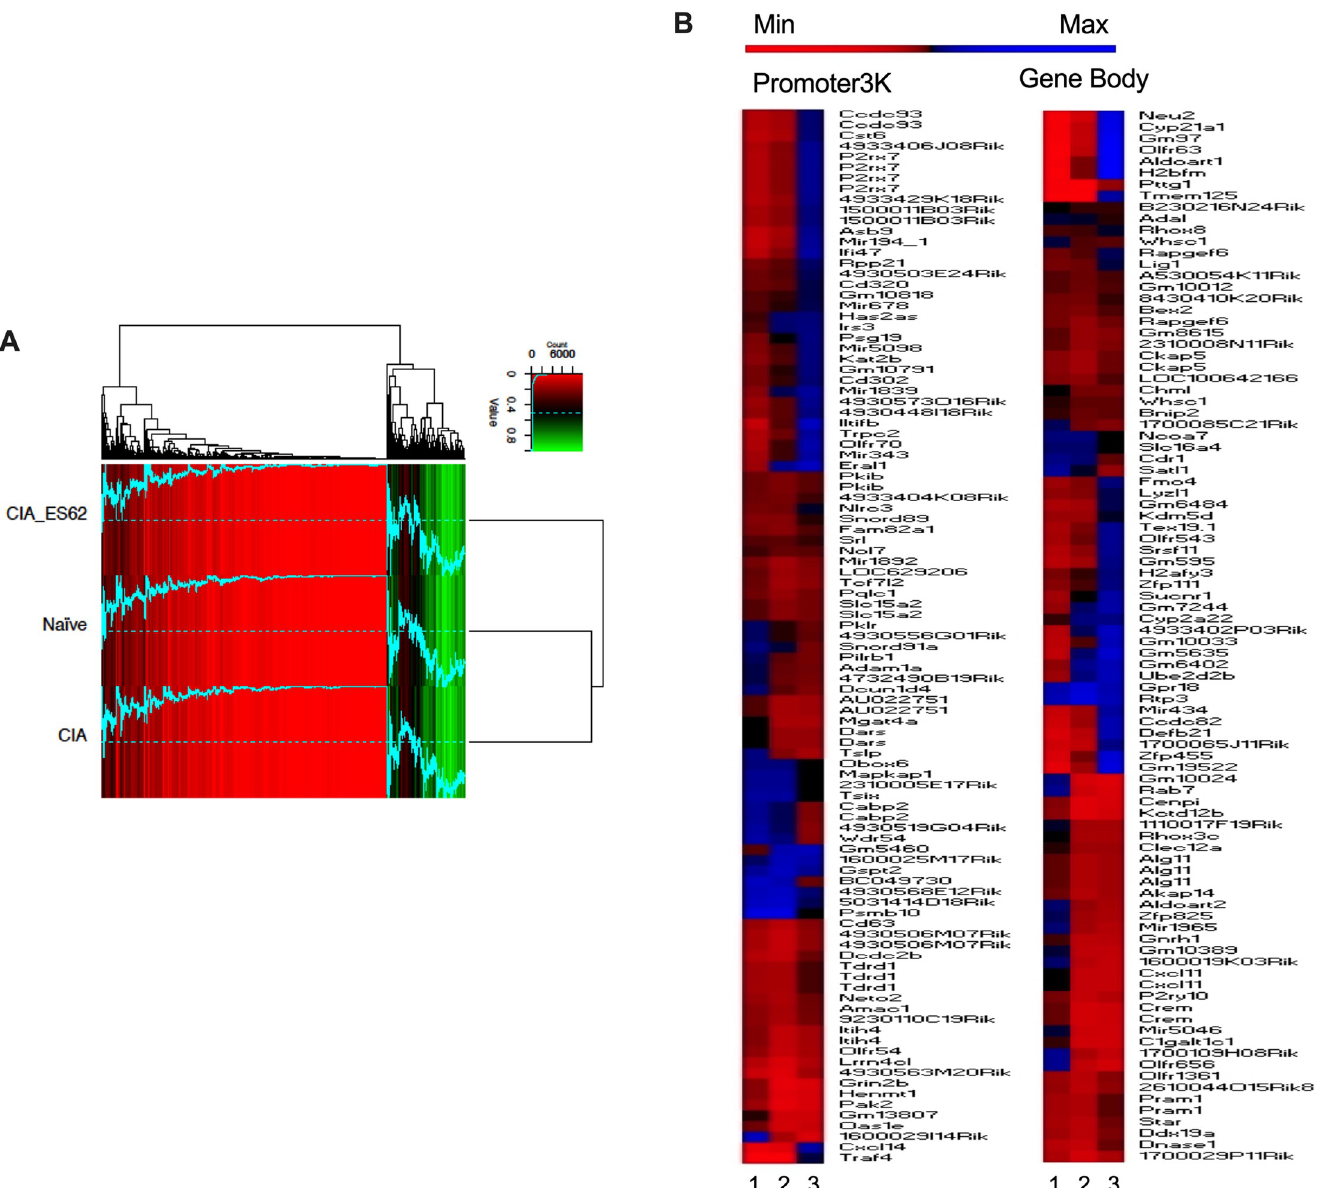
Fig 6. ES-62 induces a DNA methylation phenotype distinct from that of both Na ï ve- and CIA-SFs. RRBS DNA methylome analysis was performed on SFs from joints representative of the Na ï ve, CIA (articular score each 3 or 4) and ES-62-CIA (articular score each 0 or 1) cohorts. (A) A heatmap of methylation percentages of “Promoter2K” regions (0–2,000bp upstream of TSS) for all cohorts, hierarchically clustered using the Euclidean distance metric. Bright red indicates 0% methylation, black indicates 50% methylation, and bright green indicates 100% methylation. The blue line corresponds to the methylation percentage of the respective regions, thus facilitating visual comparison of methylation percentages across samples (the dotted line represents 50% methylation for reference). ( B ) Methylome analysis of SFs from Naive, CIA- and ES-62-CIA mice showing Heat Map analysis of the top 100 differentially methylated loci in the Promoter3K (left panel) and Gene Body (right panel) regions of total genomic DNA. In each case, hypo (red) or hyper (blue) methylation in SFs from PBS- or ES-62-treated CIA-mice relative to SFs from healthy, na ï ve mice is shown in lanes 1 and 2 respectively, whilst that of SFs from ES-62- relative to PBS-treated CIA-mice is shown in lane 3. (more closely related) Na ï ve and CIA groups ( Fig 6A ). Moreover, differential DNA methyla- tion analysis (top 100 sites) of the Promoter3K (3000 bp upstream of transcription start site [TSS]) and Gene Body (start of 5’UTR to end of 3’UTR) regions indicated that ES-62 only acted to maintain the “Na ï ve” methylation status in a limited number of genes and instead,